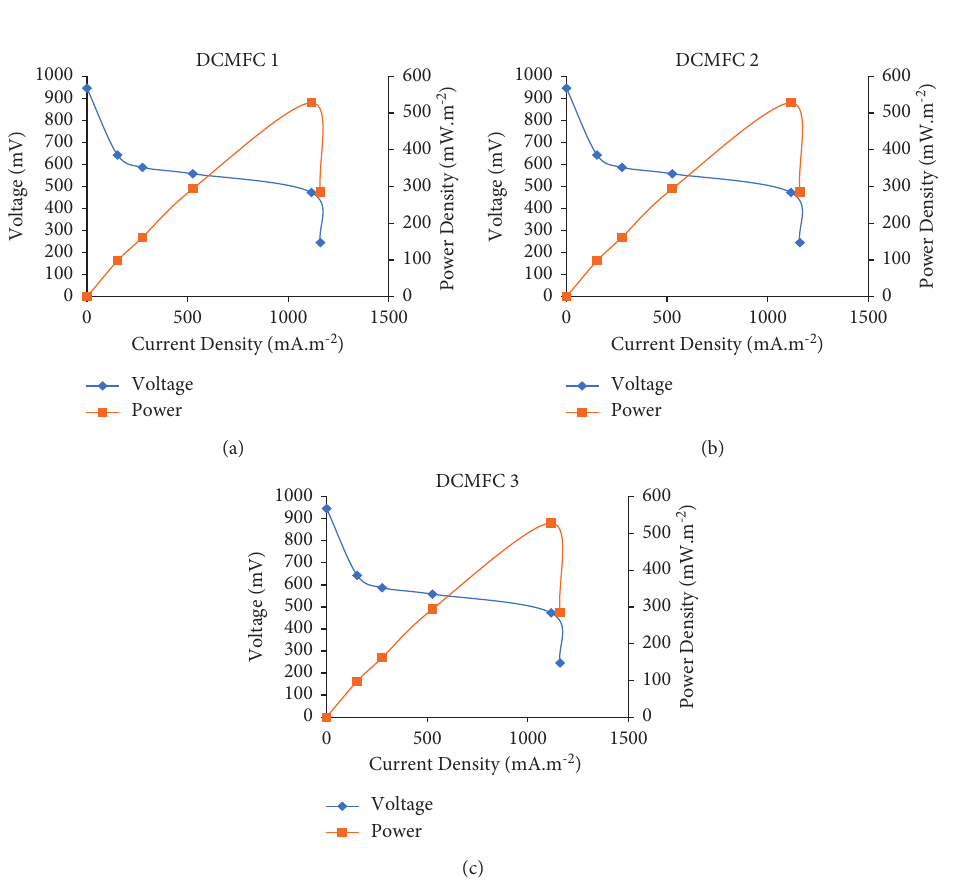
Figure 4: Polarization curves of (a) DCMFC1, (b) DCMFC2, and (c)